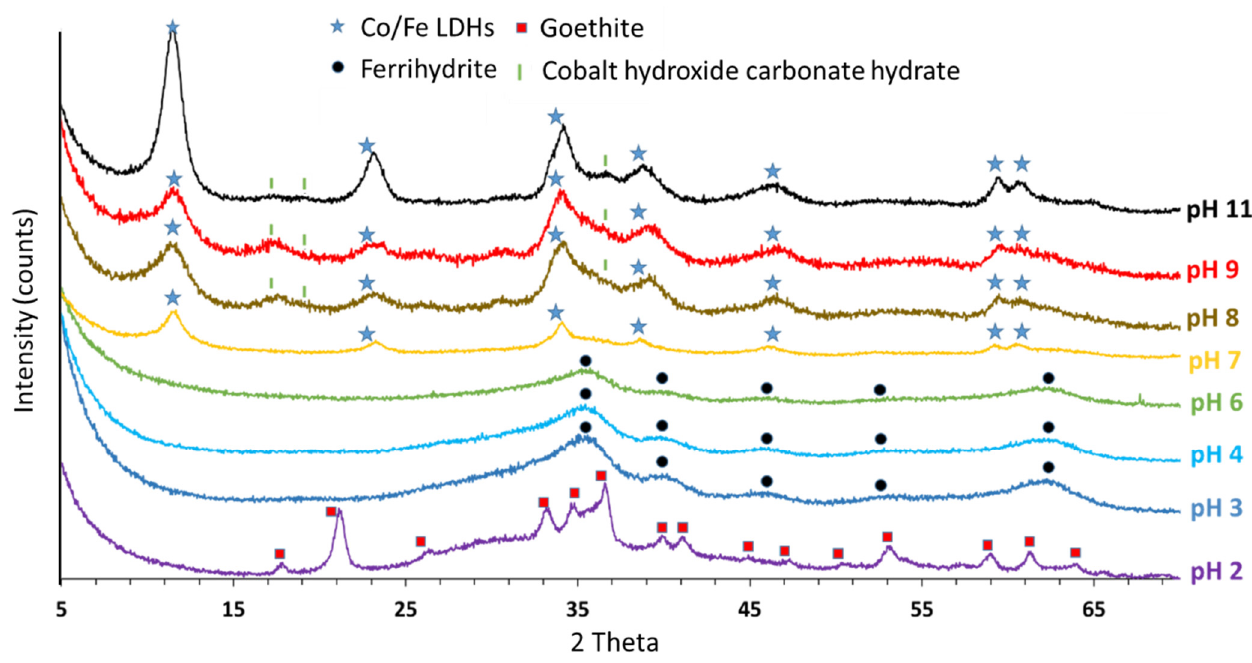
Figure 3. PXRD pattern for solids collected after titrating the starting solution up to the reported pH values.